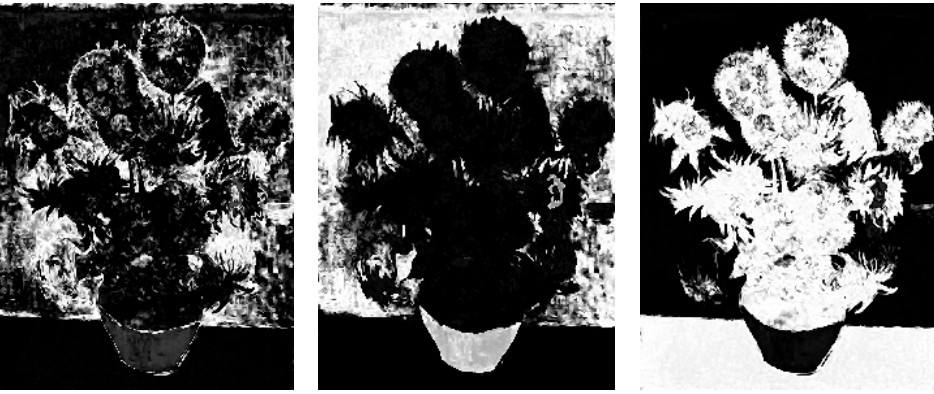
Figure 11. Sunflowers B Band—compression rate 0.25—segmented images.